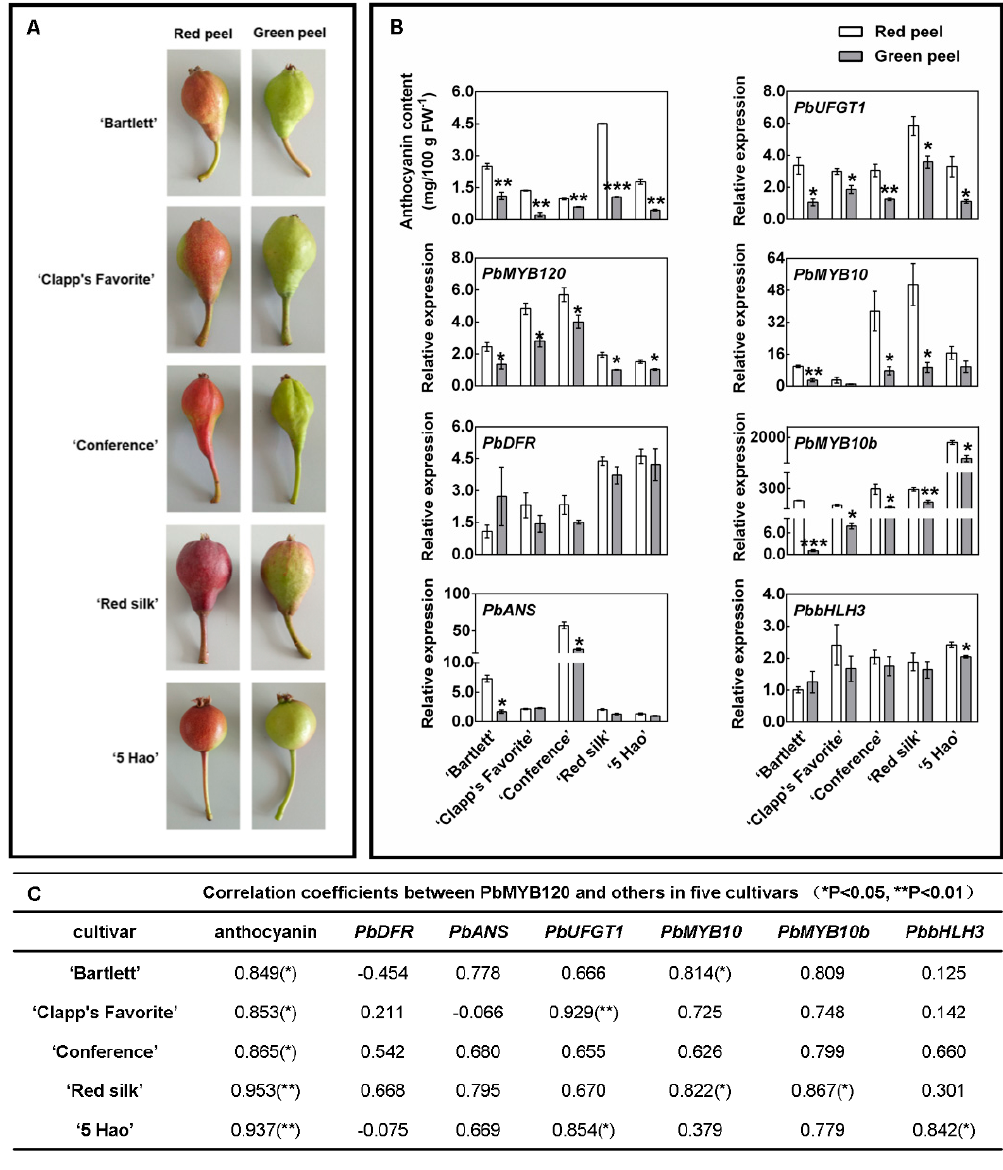
Figure 2. Expression analyses of PbMYB120 in fruit of five pear cultivars having uneven coloration. ( A ) Fruit coloration of five pear cultivars, ‘Bartlett’, ‘Clap’s Favorite’, ‘Conference’, ‘Red silk’ and ‘5 Hao’. ( B ) Analyses of anthocyanin contents and expression levels of PbMYB120 and anthocyanin biosynthesis-related genes in the red and green peels of the five tested pear cultivars. Data are the means ± standard errors (SEs) of three biological replicates. Asterisks indicate significant di ff erences as assessed by Student’s t test: * p < 0.05, ** p < 0.01, *** p < 0.001. ( C ) Correlation analyses between the expression of PbMYB120 and both anthocyanin accumulation and expressions of anthocyanin biosynthesis-related genes. Data represent Pearson’s correlation coe ffi cients that were calculated using SPSS 13.0. * p < 0.05, ** p <